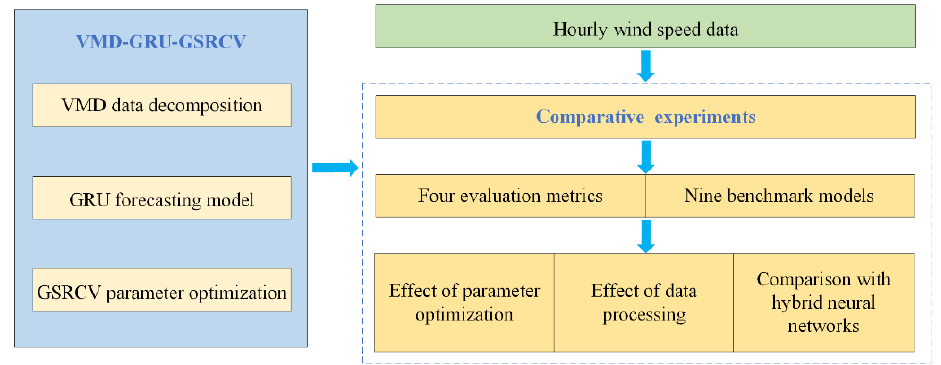
Figure 1. Flowchart of the main contents of this study.